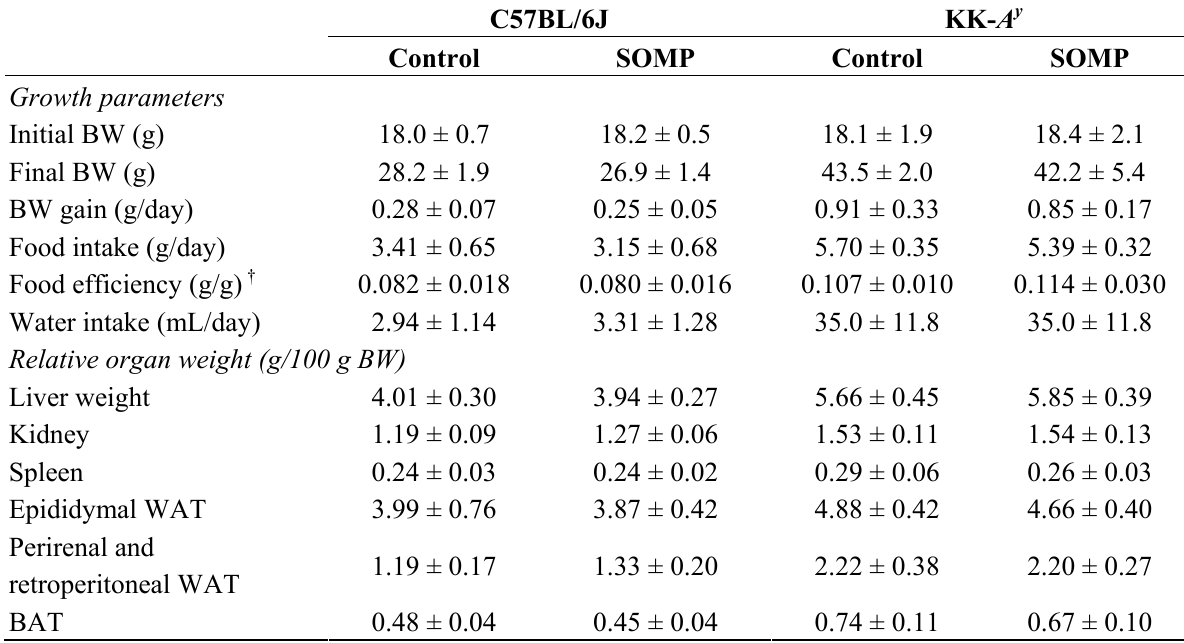
Table 4. Effect of dietary SOMP on growth parameters and relative organ weights in C57BL/6J and KK- A y